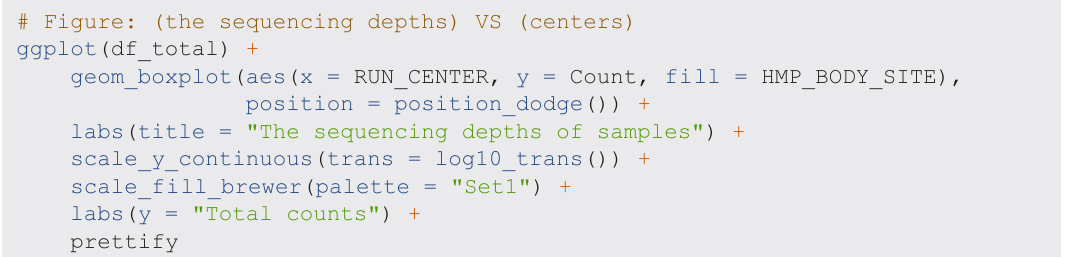
# Figure: (the sequencing depths) VS (centers) ggplot(df_total)